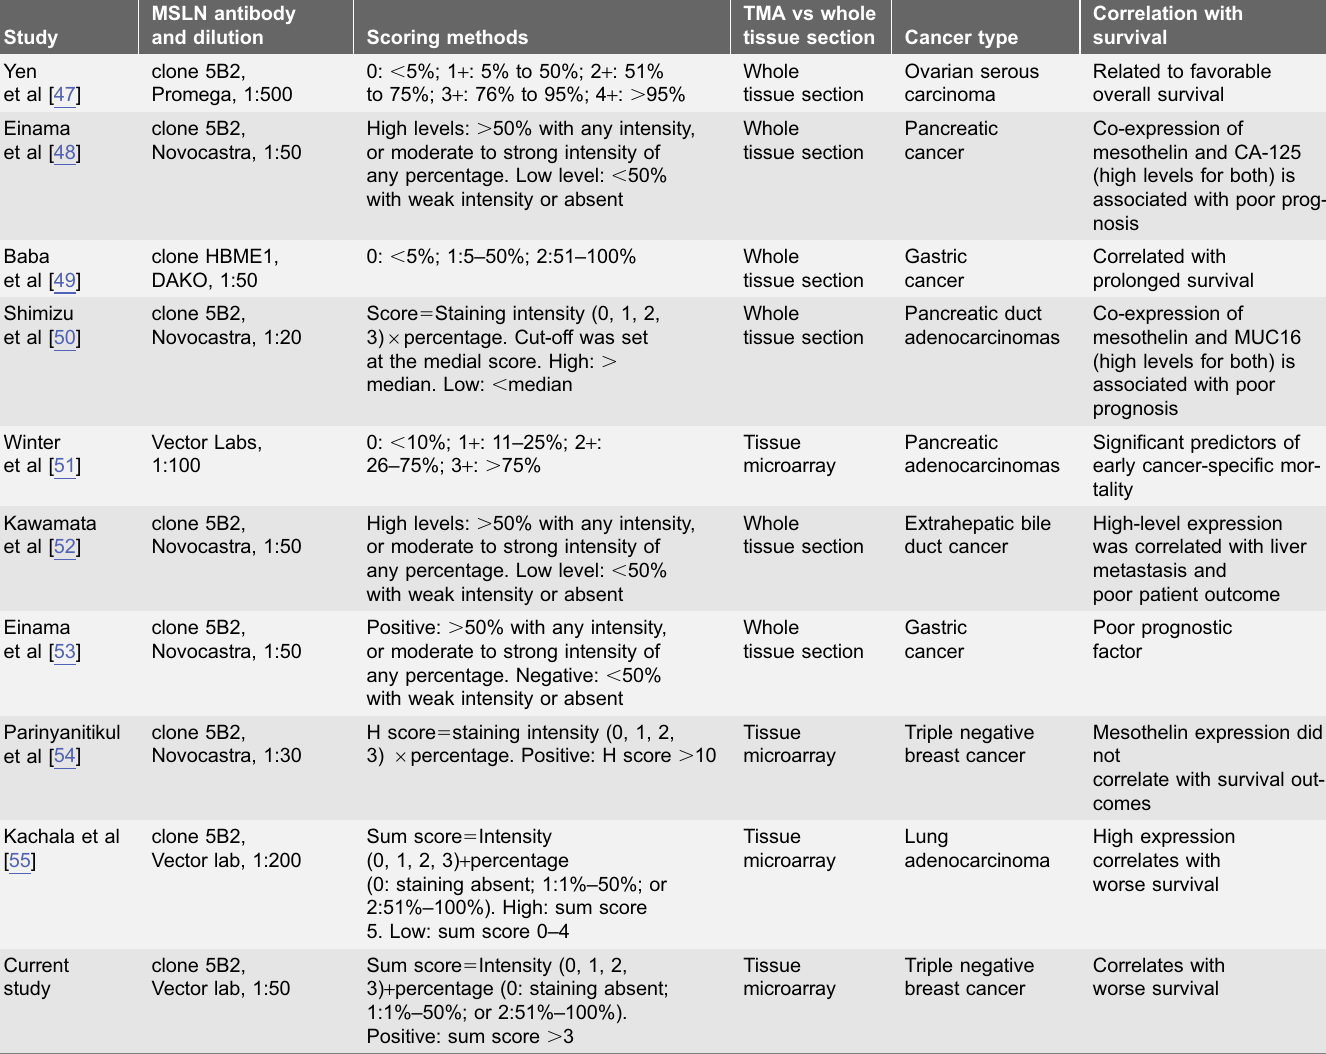
Table 7. Summary of published studies of MSLN immunohistochemical studies and correlation with survival.